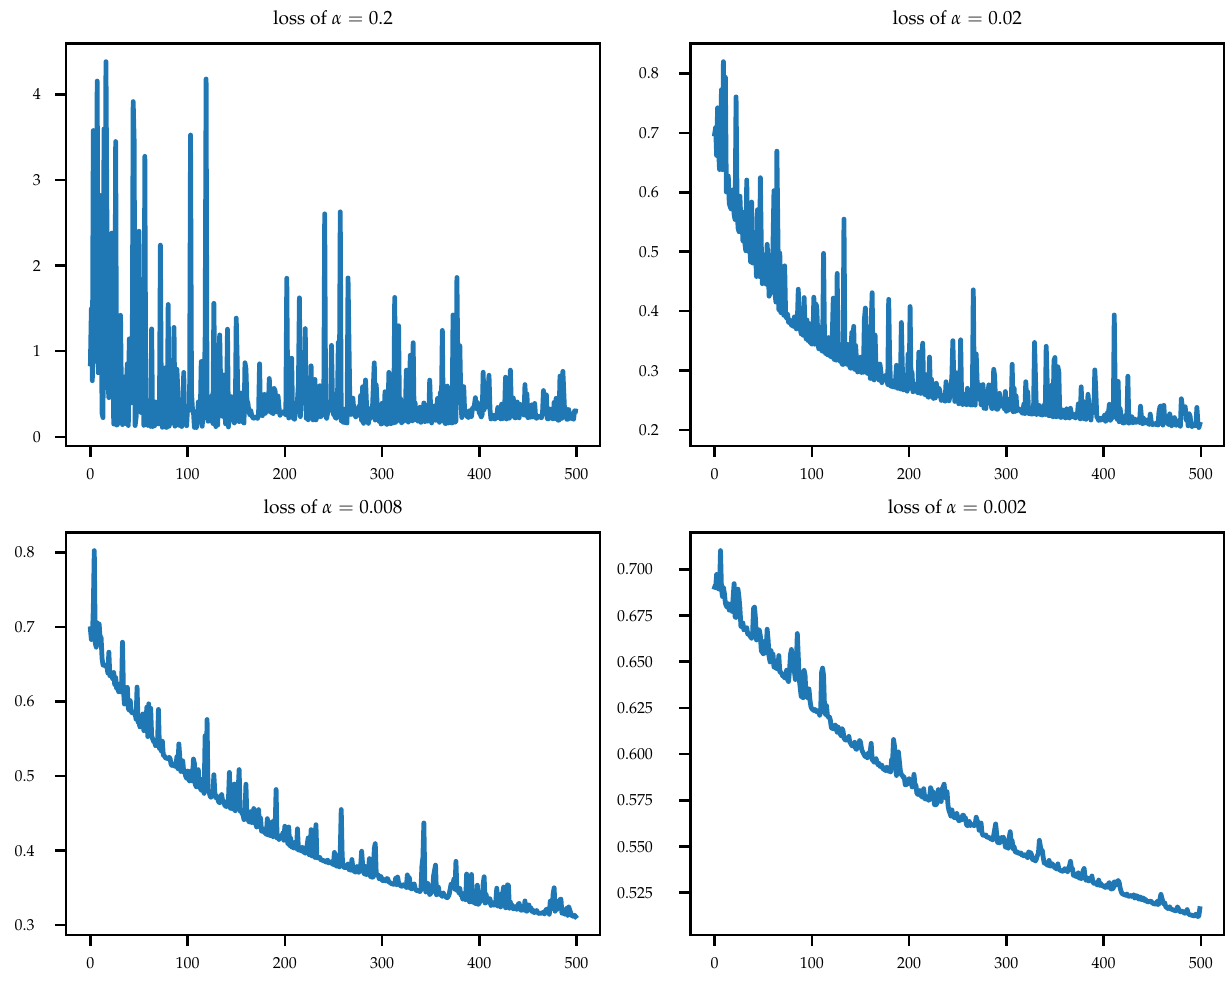
Figure 1. Training convergence under different learning rate